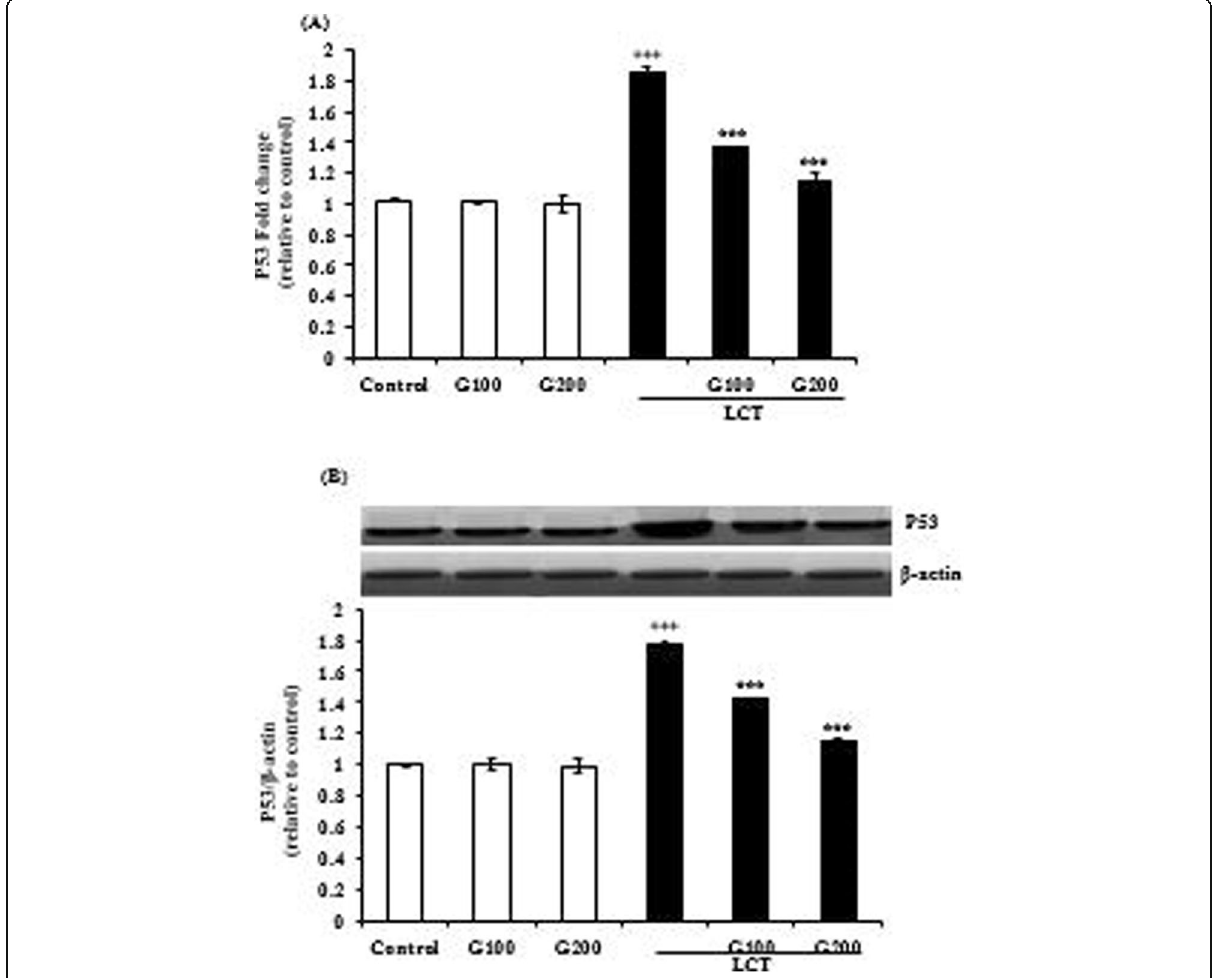
Fig. 6 Liver a P53 mRNA and b P53 protein expression levels in control, G, LCT, and LCT rats co-treated with G. The results were expressed as mean ± SE ( N = 6). Where C, control group; G, Panax ginseng injected rats; and LCT, lambda cyhalotherin administered rats. Values were considered significantly different +++ P < 0.001 versus control group and *** P < 0.001versus LCT